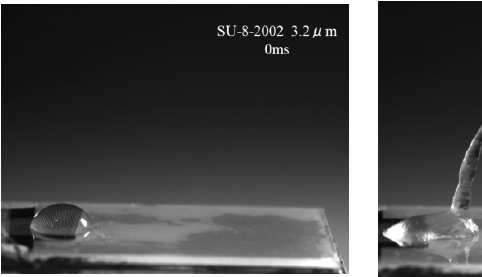
ff erent conditions.